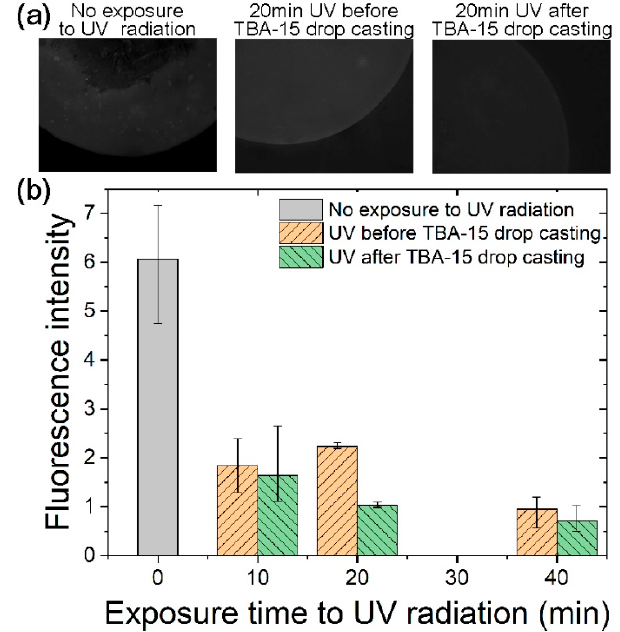
Figure 3. Analysis of fluorescence intensity for TBA–15 grafting and hybridization by means of GOPS-based functionalization with and without exposure to UV light. ( a ) Typical epifluorescence microscopy images of GOPS silanized Si/SiO 2 (100 nm) substrates in different cases regarding UV treatment (no UV exposure, 20 min UV exposure before and after TBA-15 drop casting) and after DNA grafting and hybridization. ( b ) Fluorescence intensity, as measured on fluorescence micrographs, as a function of exposure time to UV radiation. For all conditions, three fluorescent spots on the substrate were analyzed giving an average fluorescence intensity value and error bars corresponding to the minimum and maximum fluorescence intensity found for each sample.